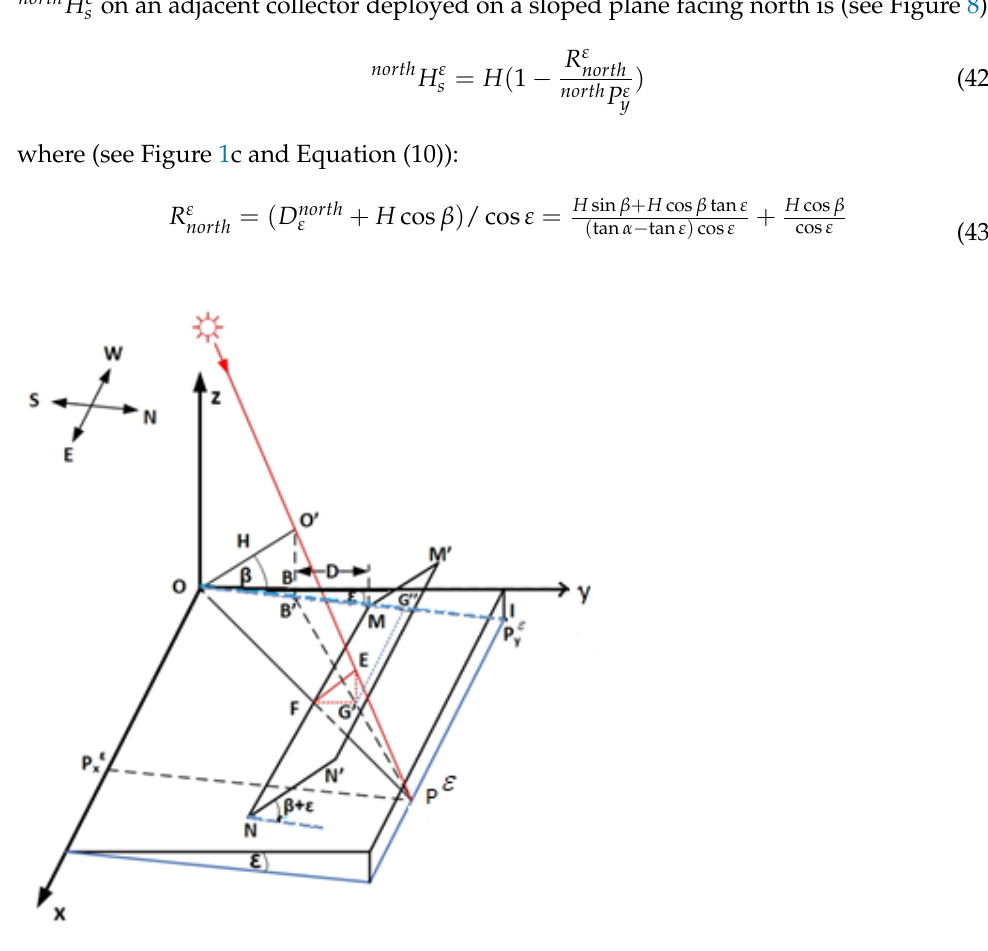
north EF H ε = on collector ' ' MNM N . s